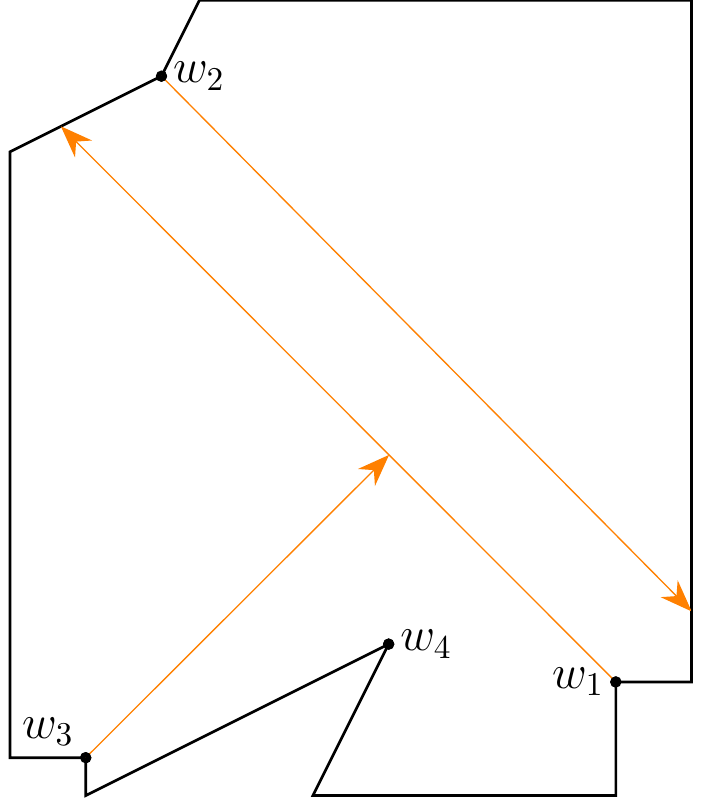
Figure 3. Partial motorcycle graph before the insertion of motorcycle m 4